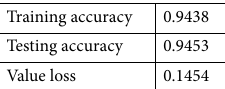
Table 1. Results of CNN1.